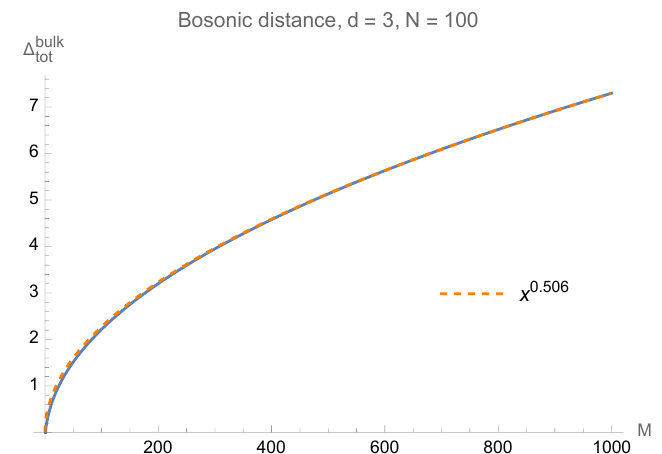
Figure 6 . Bosonic distance for d = 3 , N = 100 and M ≤ 1000 . The square-root behaviour is fitted with a power-law